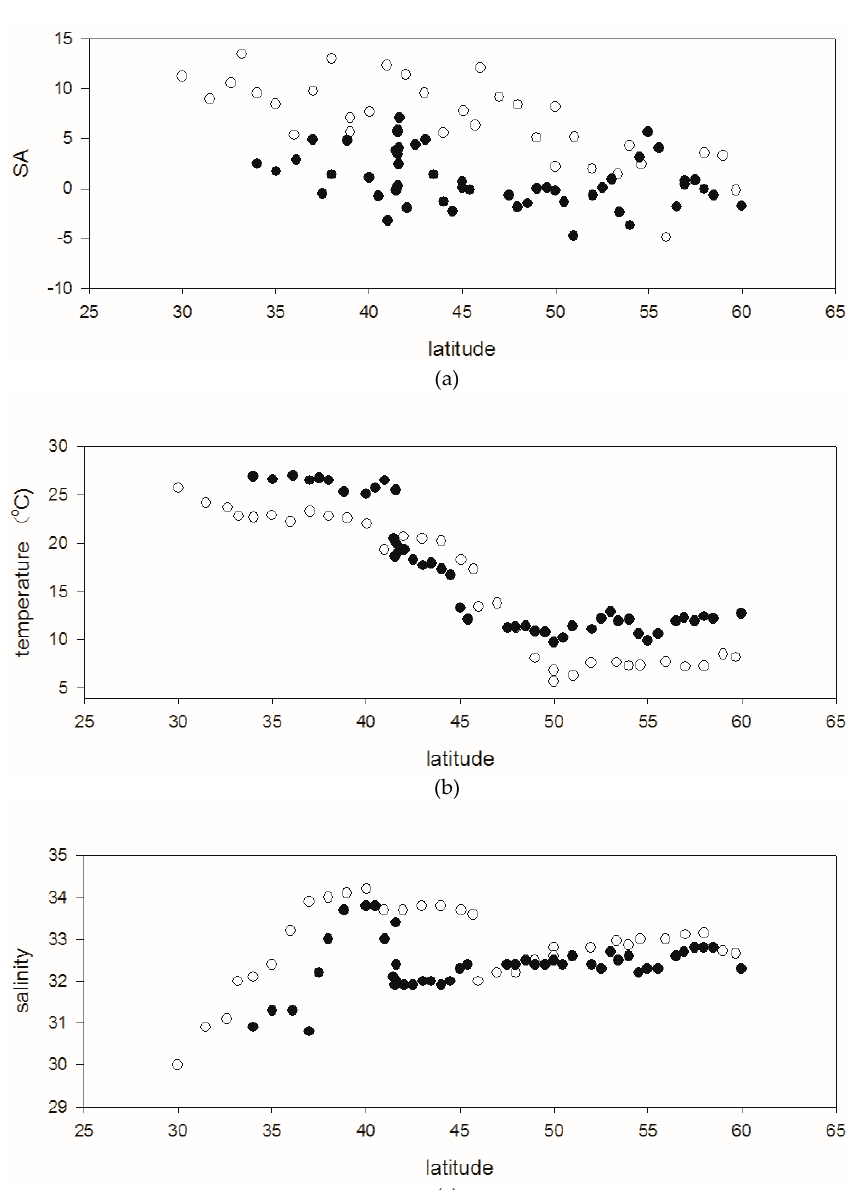
Figure 7. ( a ) The SA on the northward (open circles) and southward (solid dots) cruise tracks of the 4th Chinese National Arctic Research Expedition; ( b ) The surface water temperature on the northward (open circles) and southward (solid dots) cruise tracks of the 4th Chinese National Arctic Research Expedition; ( c ) The surface water salinity on the northward (open circles) and southward (solid dots) cruise tracks of the 4th Chinese National Arctic Research Expedition.